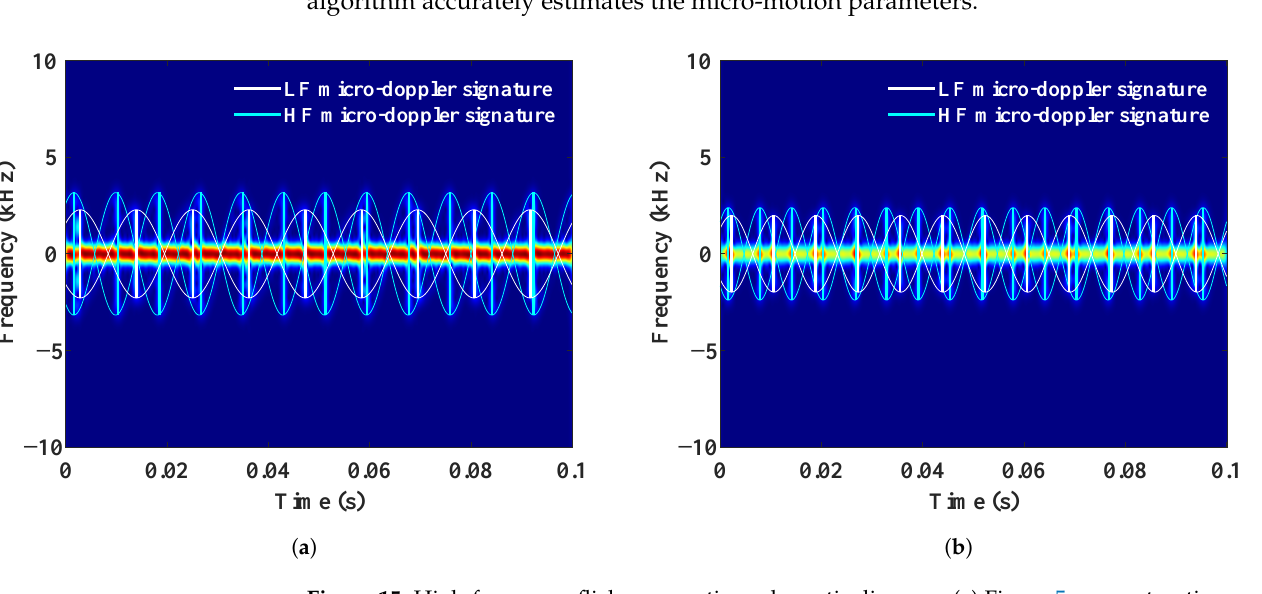
Figure 15. High-frequency flicker correction schematic diagram. ( a ) Figure 5c reconstruction result. ( b ) Figure 5d reconstruction result. Table 2. Micro-Doppler parameter estimation and real value